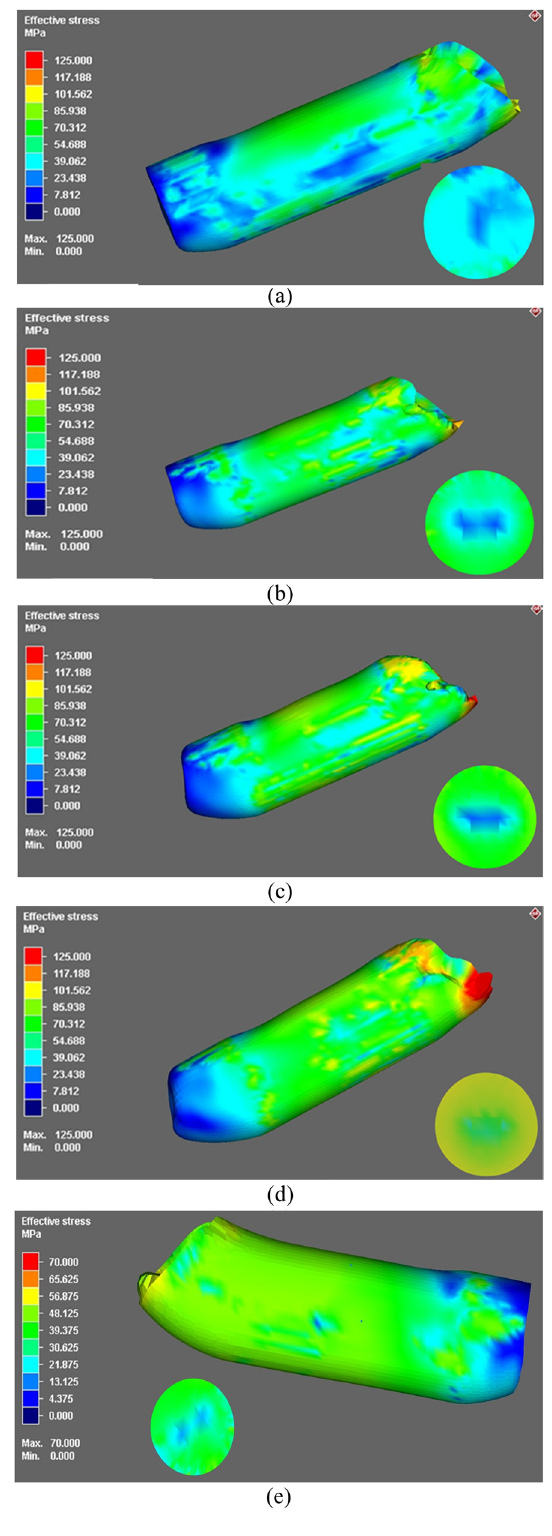
Figure 3: Stress distribution along both the LS and TS of the Cu billets processed through ECAP using the 90° - die through 1 - P ( a ) , 2 - Bc ( b ) , 3 - Bc ( c ) , 4 - Bc ( d ) at RT, and 1 - P ( e ) at